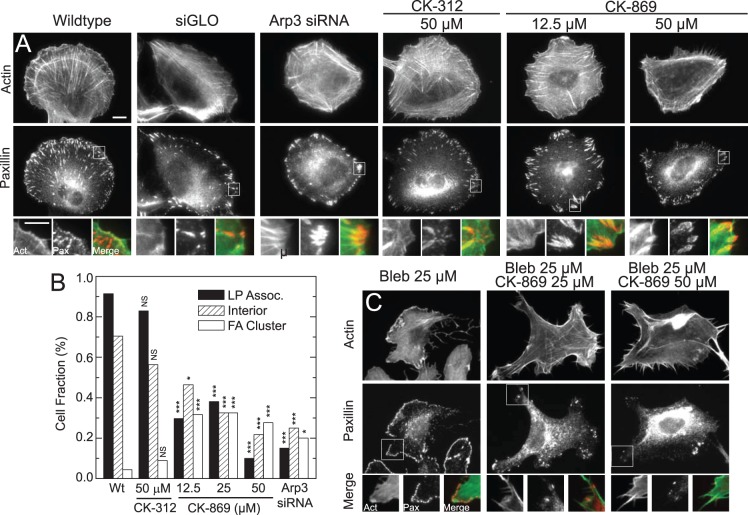
Arp2/3 inhibited cells show fewer nascent focal adhesions, fewer interior focal adhesions, and large focal adhesion clusters.(A)Top panel consists of images of F-actin visualized by fluorescent phalloidin (top row) and paxillin immunofluorescence (middle row) and enlargements of regions of interest (bottom row) for wild type, siGlo cells, siRNA Arp3 and cells treated for four hours with inidicated concentrations of either control (CK-312) or Arp2/3 inhibitor (CK-869). (B) Plot of focal adhesion phenotypes as a function of inhibitor concentration or siRNA. Cells with lamellipodia-associated adhesions were cells with focal adhesions less than 0.3 µm2 found in lamellipodia. Cells with interior adhesions were cells with focal adhesions found at least 5 µm away from the cell edge. FA cluster are cells containing dense clusters of focal adhesions, as shown in inset of siArp3 and 12.5 µM CK-869 images. All focal adhesions in the cells were counted (n = 43, 32, 45, 38, 48, 19) NS, not significant; *, P<0.05; ***, P<0.001 with respect to WT or control. (C) Images stained as in (A) treated with 25 µM Blebbistatin and the indicated concentration of CK-869.